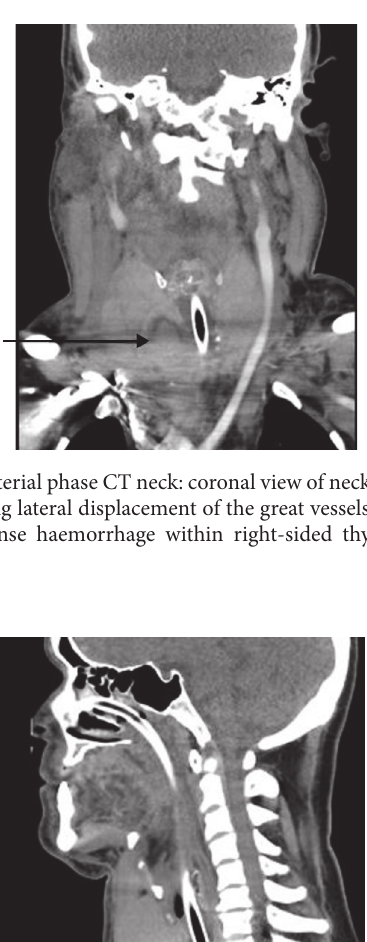
Figure 4: Postoperative specimen of the goitrous right lobe of the thyroid gland, with the right-sided nodule clearly visible adjacent to the isthmus (white arrow), from which the pulsatile arterial haemorrhage was identified